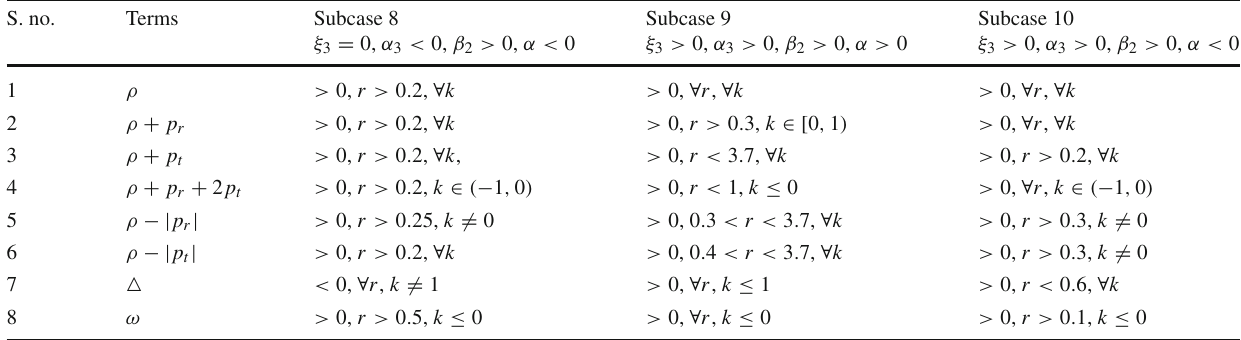
Table 9 Results for Form III: ρ = α 3 R 2 + β 2 R (cid:2) e ξ 3 R S. no.